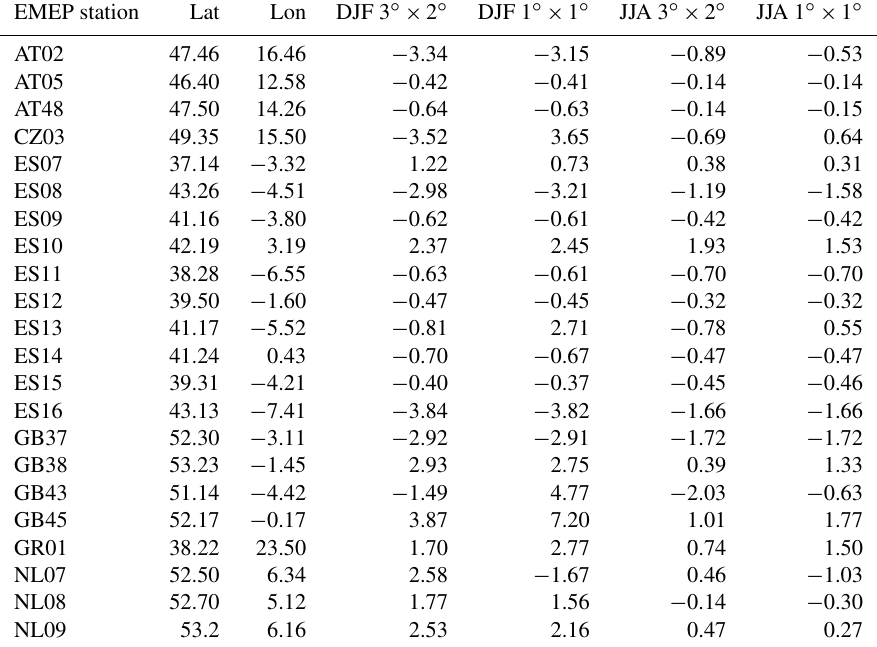
Table 9. The seasonal mean biases of daily [SO 2 ] (µgm − 3 ) at 13:00 for DJF and JJA, when taking the difference between measurements– model values. Values are shown for both the 3 ◦ × 2 ◦ and 1 ◦ × 1 ◦ simulations. Those with differences < 5% are considered to exhibit no discernible change in the